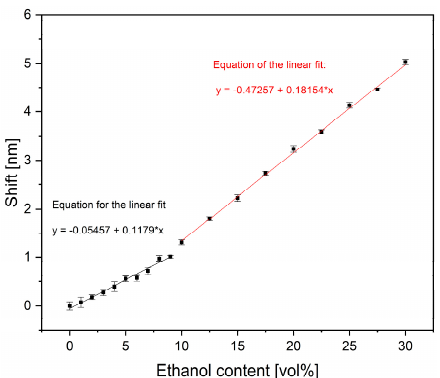
Figure 5. Shift of the resonance wavelength with increasing ethanol content due to the deswelling of the PAM hydrogel showing a linear behavior of the refractive index change.